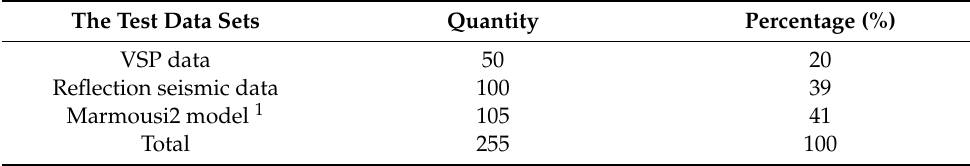
Table 2. Quantity of the test data sets